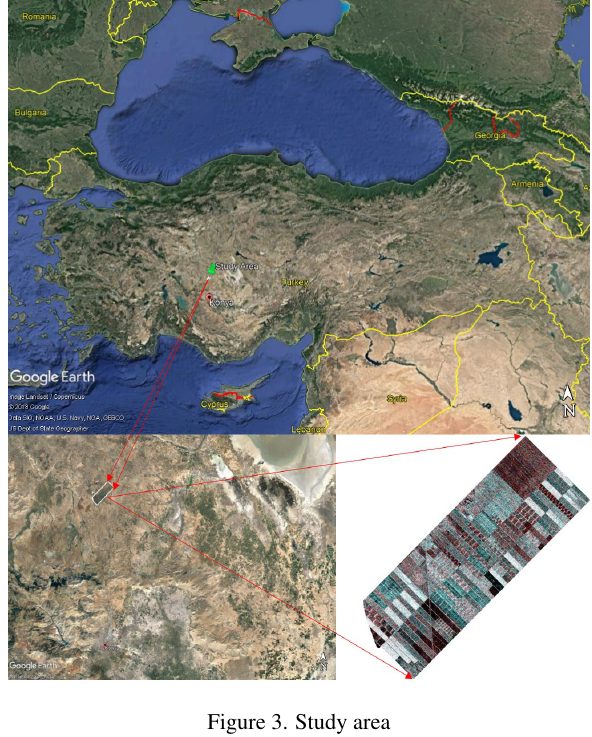
Figure 3. Study area